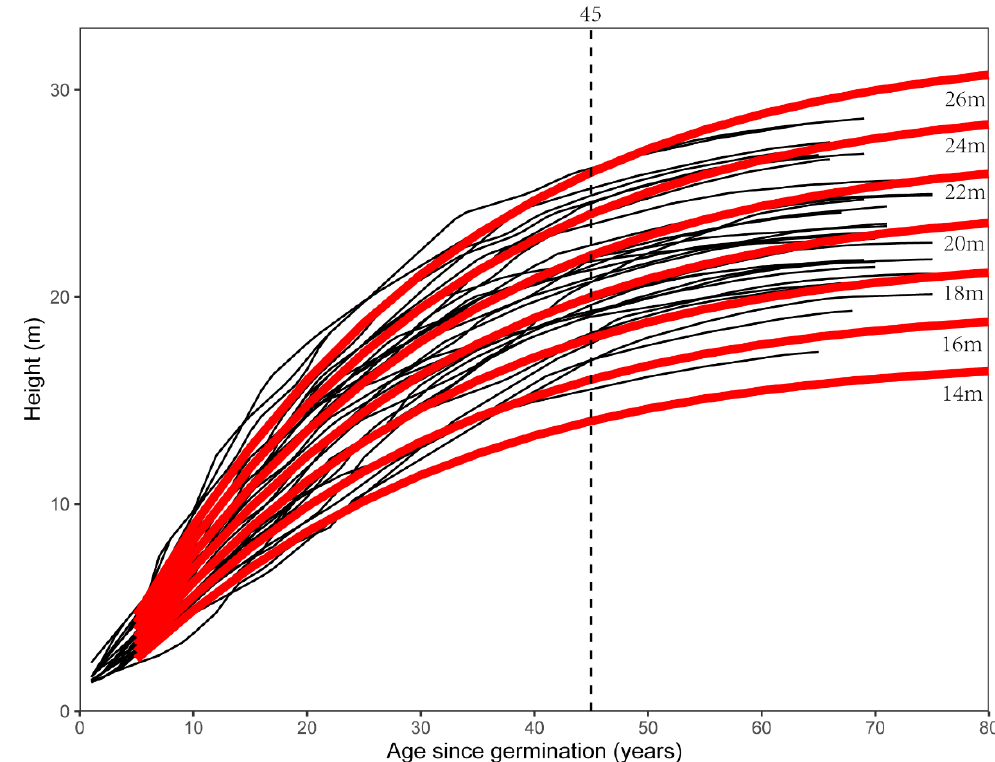
Figure 6. The new height growth model (Equation (19)) for curves corresponding to a site index with a 2 m interval of 14 m to 26 m (dominant height at age 45).